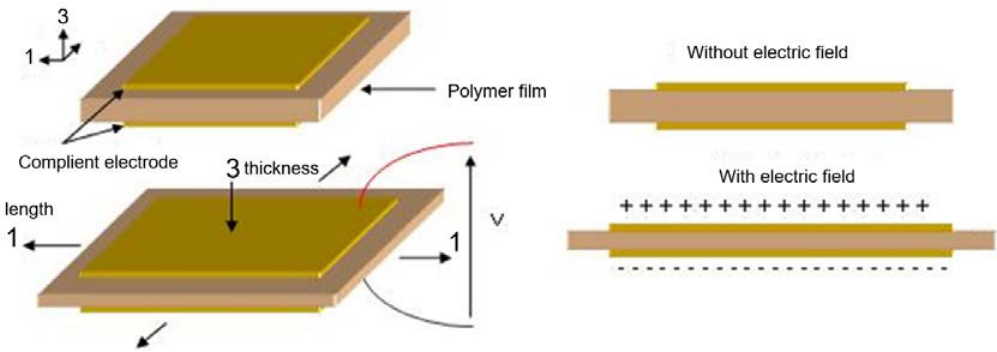
Figure 1. Principle schematic of the electrostrictive actuation.